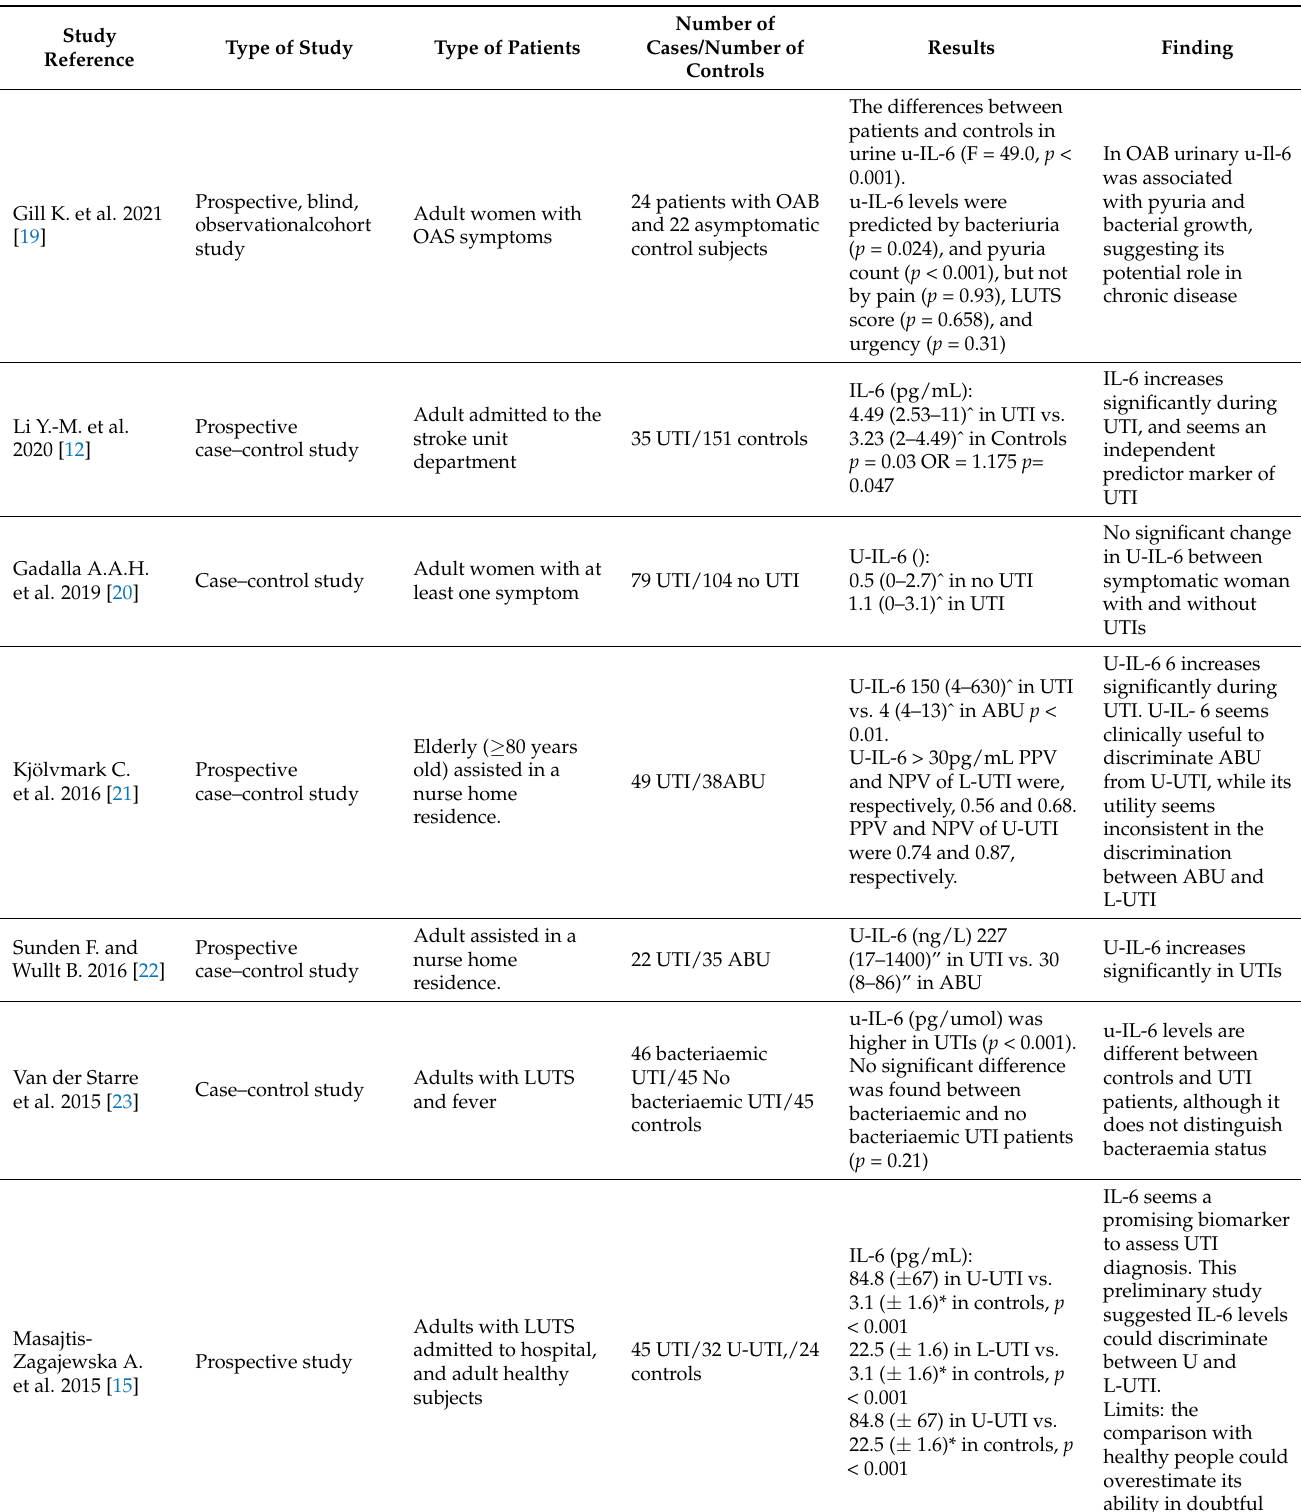
Table 2. Serum and urine interleukin-6 diagnostic value in UTIs, with a target population of